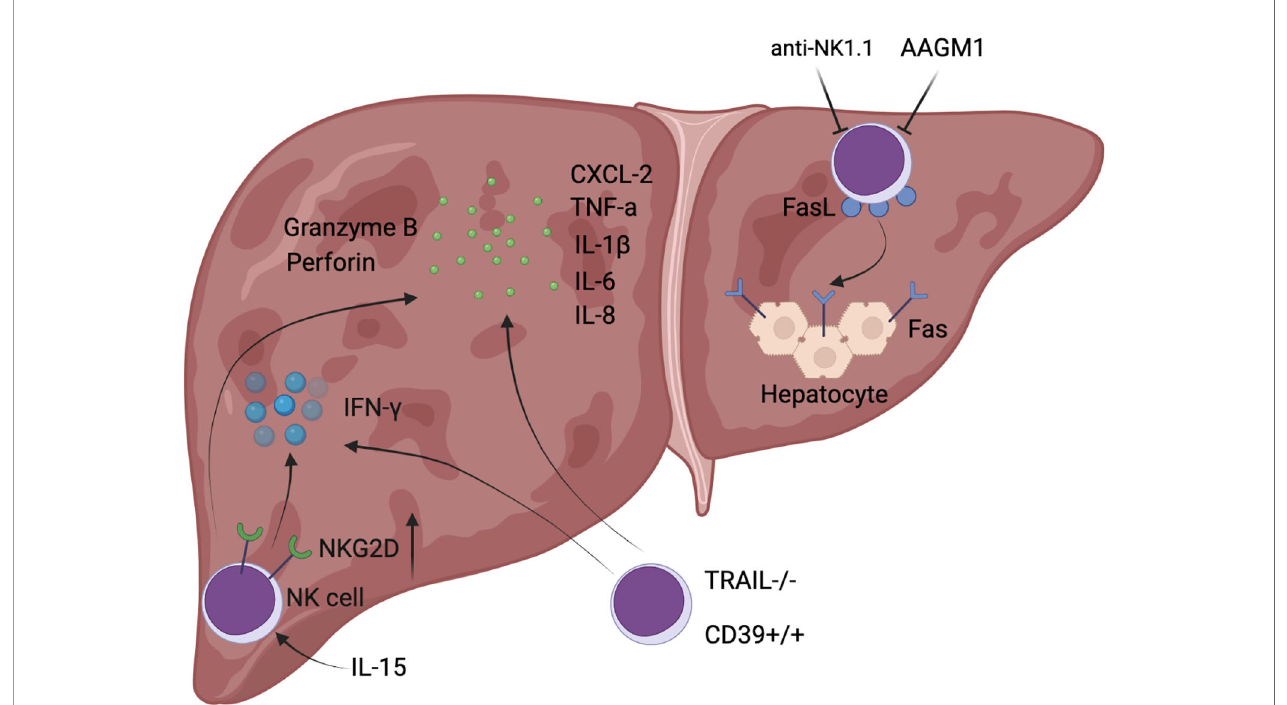
FIGURE 1 | Diagrammatic sketch of NK cell-mediated exacerbated liver injury during hepatic